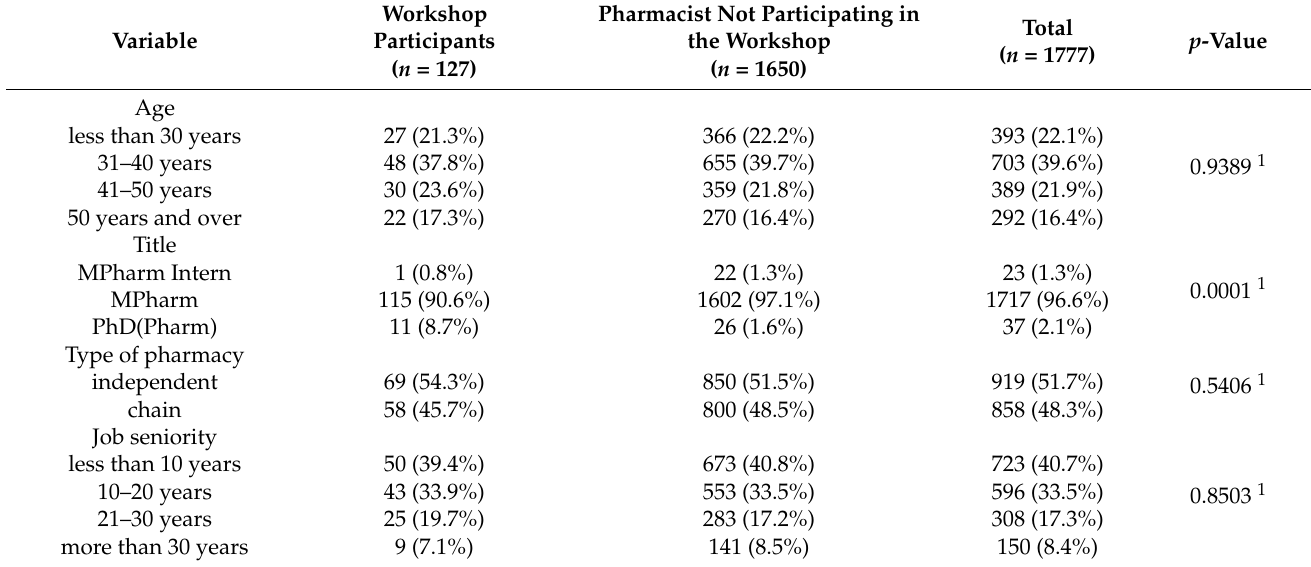
Table 1. Basic characteristics of the pharmacists participating in the Pharmacists Without Borders workshops (Group Yes) and the pharmacists not participating in the Pharmacists Without Borders workshops (Group No) by age, title, type of pharmacy, and job